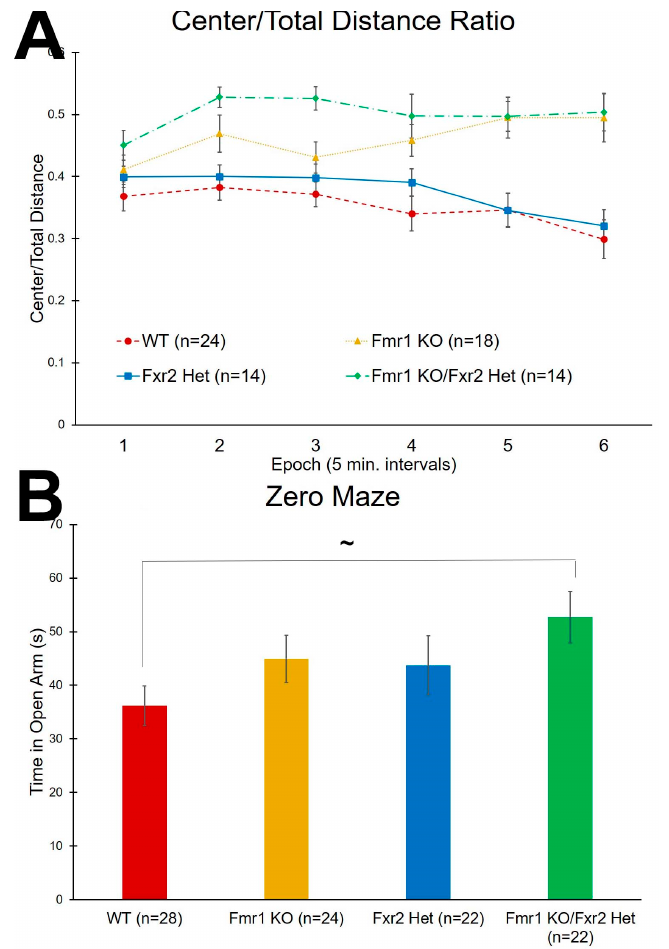
Figure 3. Tests for anxiety-like behavior. ( A ) In the open field test, the ratio of center distance to total distance traveled is an inverse measure of anxiety-like behavior. The genotype × epoch interaction was statistically significant ( p = 0.005). Overall, Fmr1 KO/ Fxr2 Het mice traveled more relative distance in the center than WT mice throughout the test. Similarly, Fmr1 KO also traveled more relative distance in the center than WT mice in almost every epoch of the test (Table 2). Fmr1 KO (Epochs 5 and 6) and Fmr1 KO/ Fxr2 Het mice (Epochs 2, 3, 5, and 6) also traveled more relative distance in the center than Fxr2 Het mice. In epoch 3, Fmr1 KO/ Fxr2 Het mice traveled more relative distance in the center than Fmr1 KO mice. Each point represents the mean ± SEM for the number of mice indicated on the figure. ( B ) In the zero maze, the time spent in the open portions of the maze is an inverse measure of anxiety-like behavior. The effect of genotype approached statistical significance ( p = 0.084) so we proceeded with post-hoc t-tests. Fmr1 KO/ Fxr2 Het mice tended to spend more time in the open portions than WT mice ( p = 0.065). Each bar represents the mean ± SEM for the number of mice indicated on the figure. ~, 0.05 ≤ p ≤ 0.10.